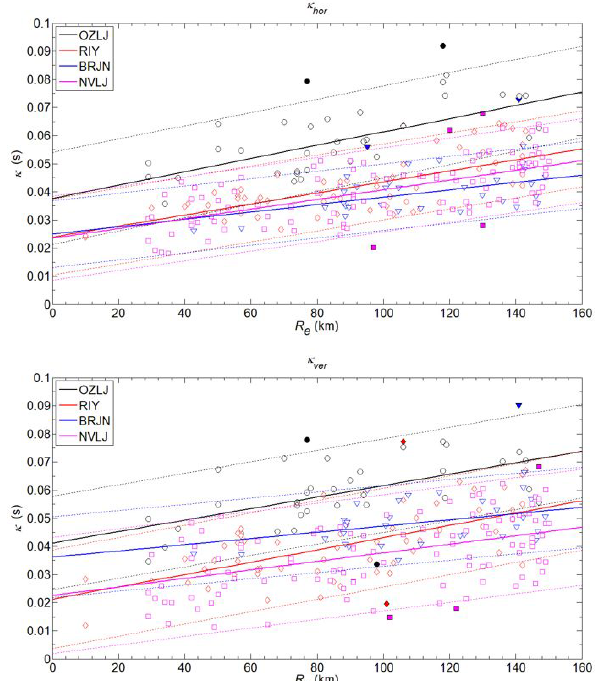
Figure 5. Horizontal and vertical κ − R e models for each seismo- logical station. Site-specific attenuation values of κ hor , ver at zero distance R e ) and regression slopes κ hor , ver ble 2. Full markers are regression outliers outside of a 95% confi- dence interval (dashed